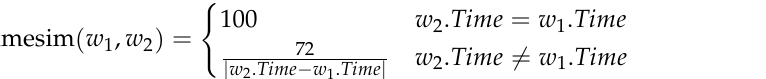
Figure 4. LDA model potential subject topology diagram.